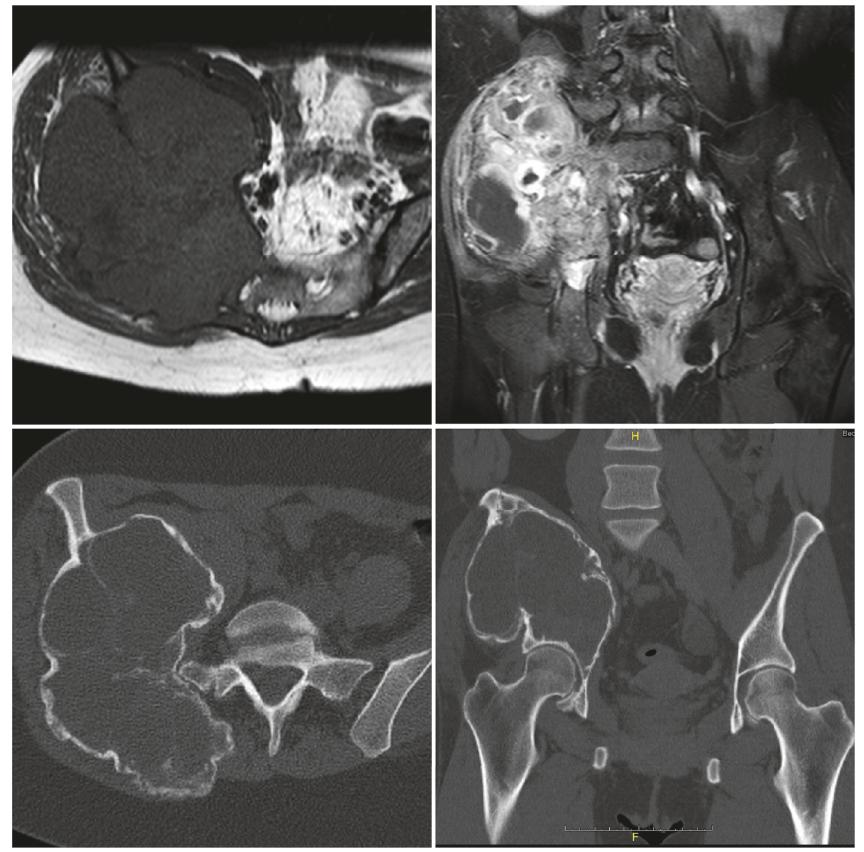
Figure 1: Initial MR and CT Imaging showing a substantial right-sided cystic tumor of the pelvis infiltrating associated neuroforamina.